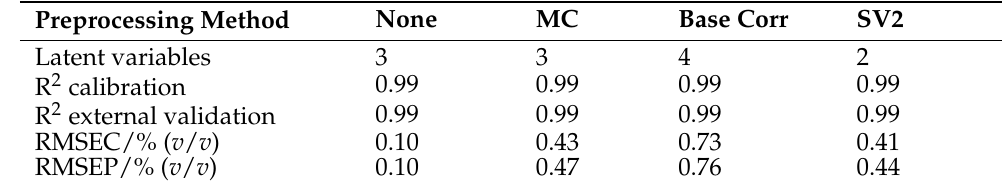
Figure 3. FT-NIR spectra of pure diesel and the DPB blend preprocessed with ( a ) baseline correction; ( b ) 2nd order derivative, and ( c ) the corresponding PCA of 2nd order derivative, between 4000 and 6800 cm − 1 , of pure diesel (DP) and diesel with varying concentrations of biodiesel. Table 5. PLS models based on FT-NIR spectra between 6800 and 4000 cm − 1 , with diverse preprocess- ing methods to determine biodiesel content in the DPB blend (0 to 15% ( v / v